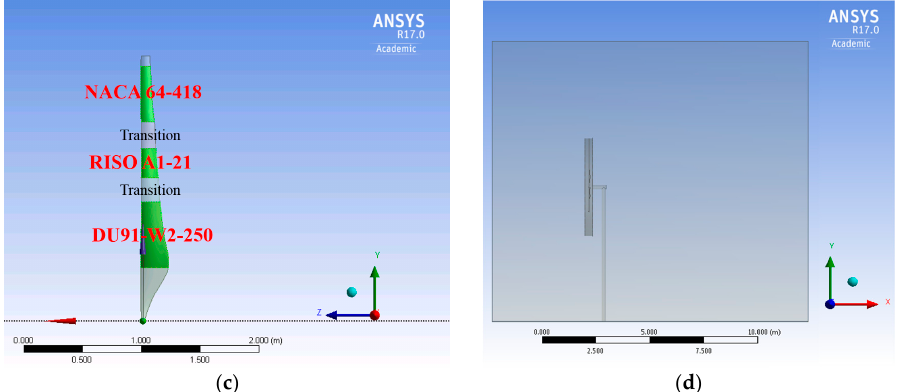
Figure 1. ( a ) Physical domain with two rotors and boundary conditions; ( b ) front view of the physical domain, showing the MEXICO (Model Experiments in Controlled Conditions) rotor; ( c ) MEXICO rotor geometry, a three-bladed rotor with a 4.5 m diameter; and ( d ) lateral view of the wind turbine, showing the rotating reference frame.